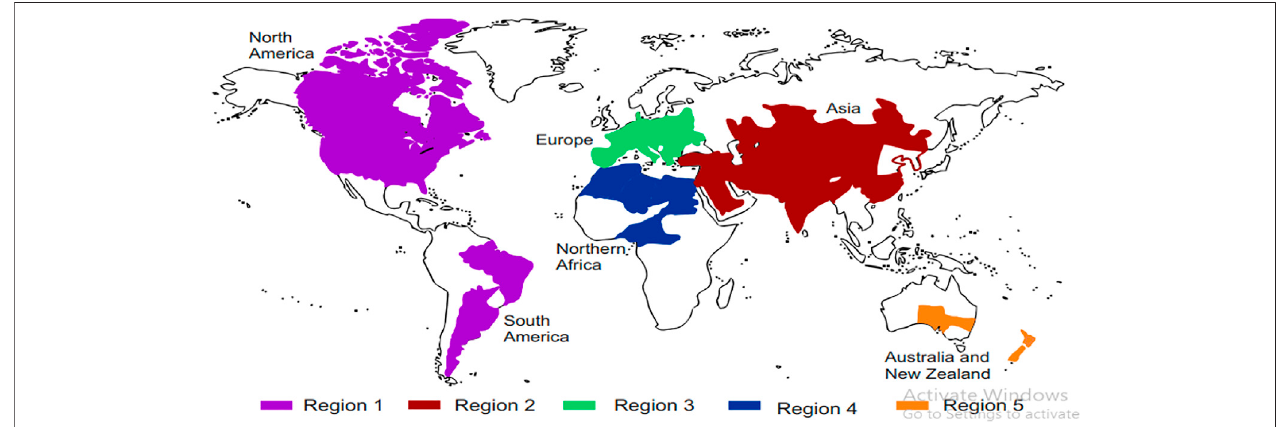
FIGURE 3 | Distribution of shikonin-producing plants around the world. Region 1 — North and South America, Region 2 — Asia, Region 3 — Europe, Region 4 — Africa, and Region 5 — Australia and New Zealand ( Table 2 ).